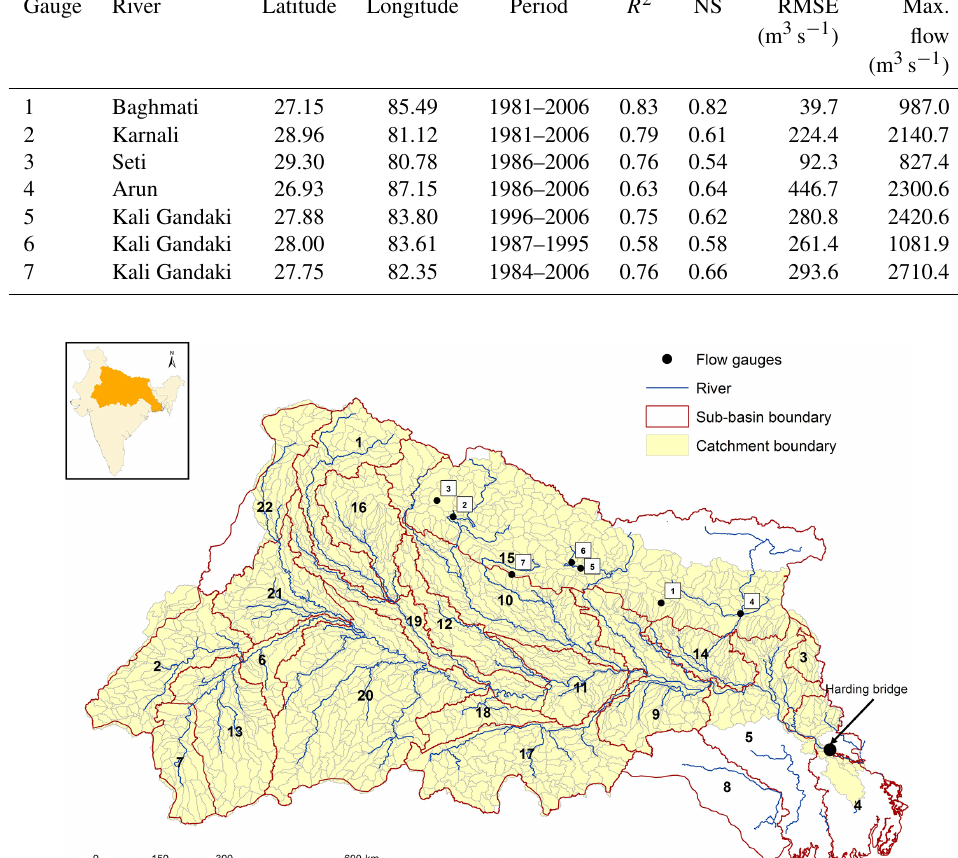
Figure 1. Sub-basins and catchments of the Ganges River basin (names of the sub-basins are given in Table 3).